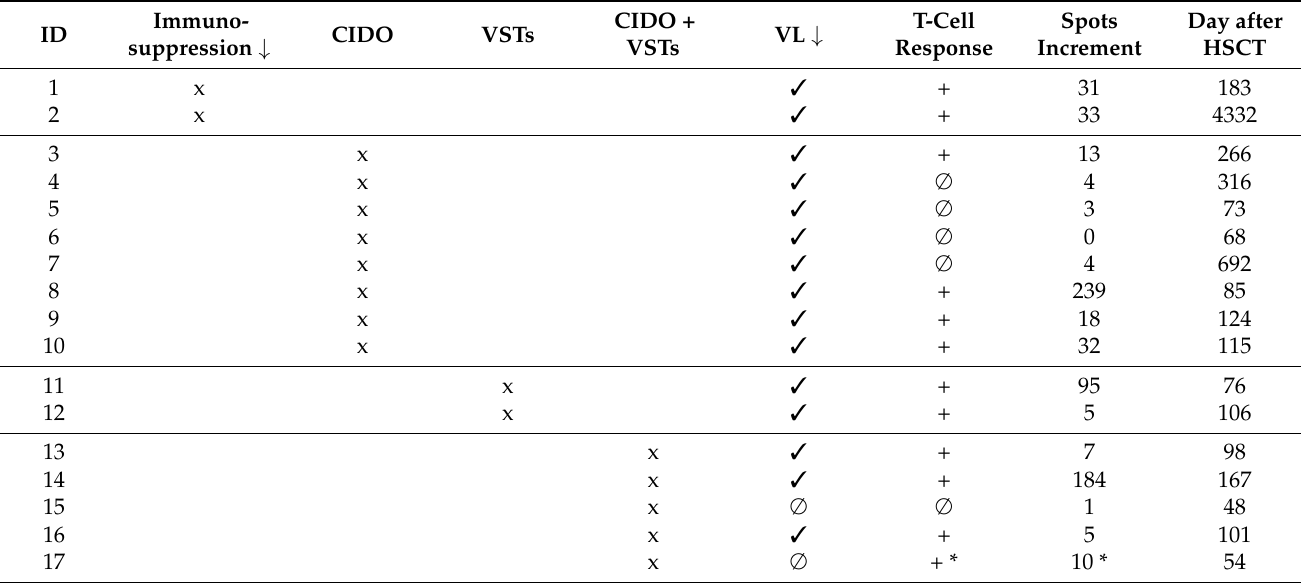
Table 2. Assessment of treatment responses in 17 hematopoietic stem cell transplant recipients with BKV-related